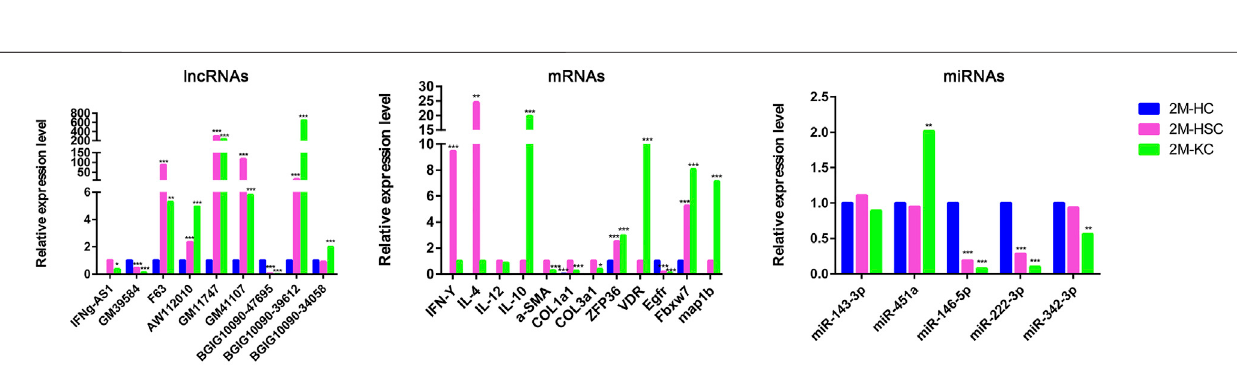
Frontiers in Cell and Developmental Biology |